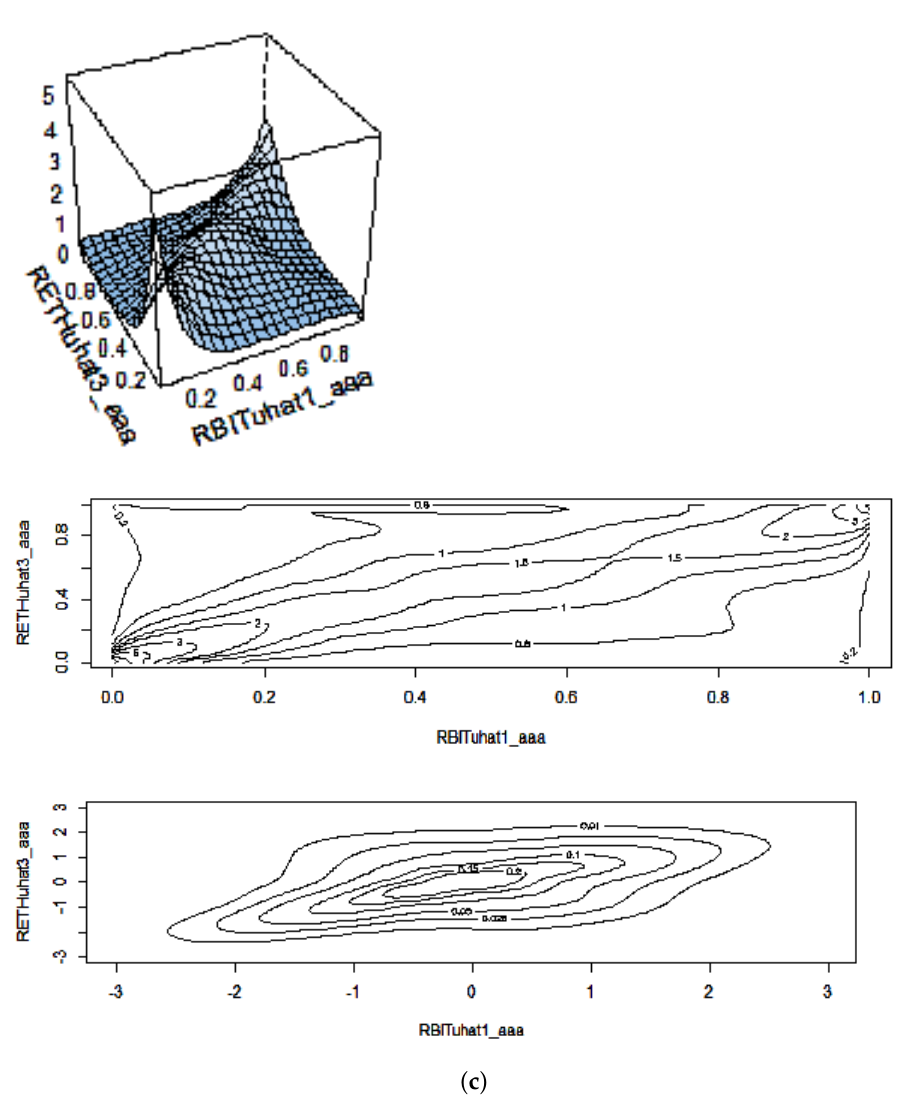
Figure 3. Kernel Density Estimates of Copula fitted to Ajusted Return Series Period 1 Pre-COVID-19. ( a ) Panel A: BITRET and SPRET. ( b ) Panel B: ETRET and SPRET. ( c ) Panel C: BITRET and